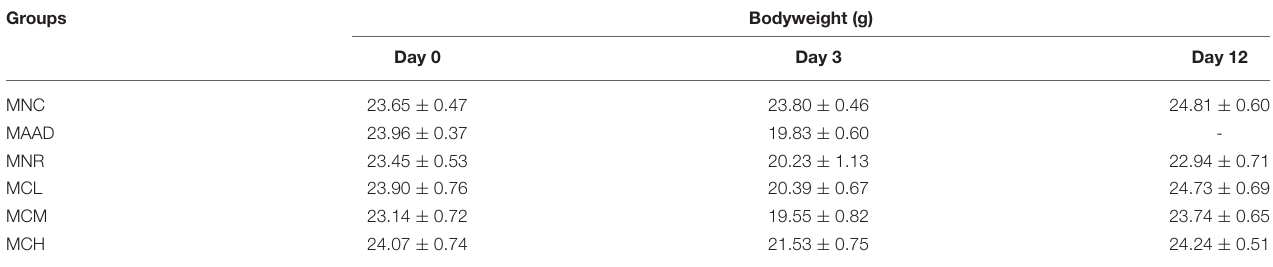
TABLE 2 | Effects of CSP-1 on the body weight of mice.